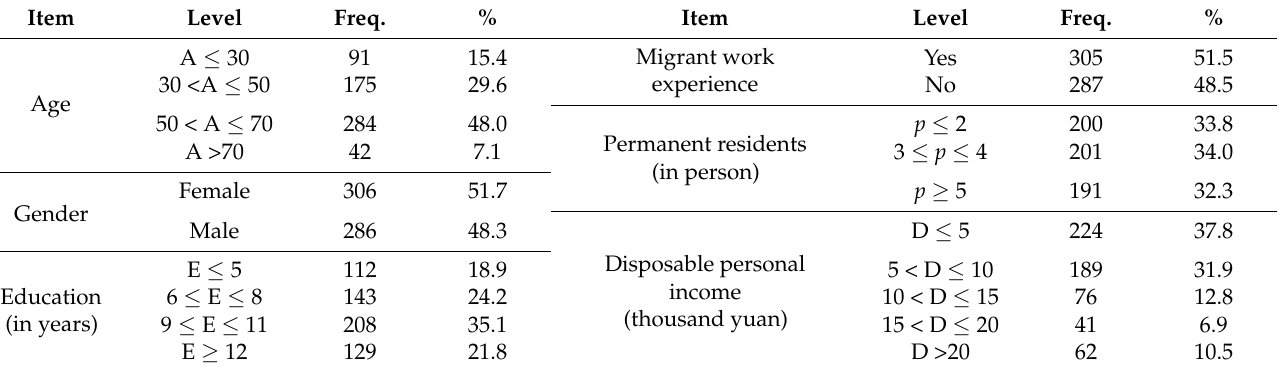
Table 1. Socioeconomic characteristics of the